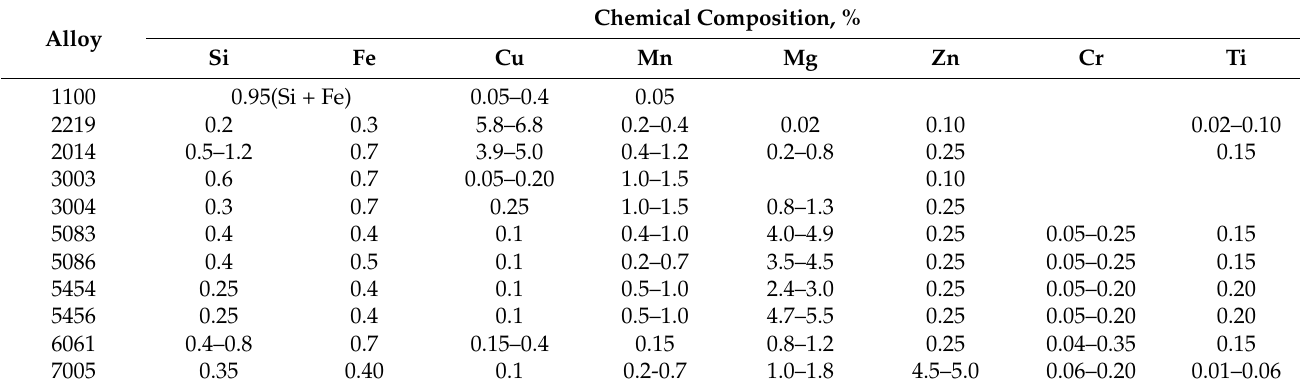
Table 2. Chemical composition of aluminum alloys commonly used in cryogenic temperatures [24].